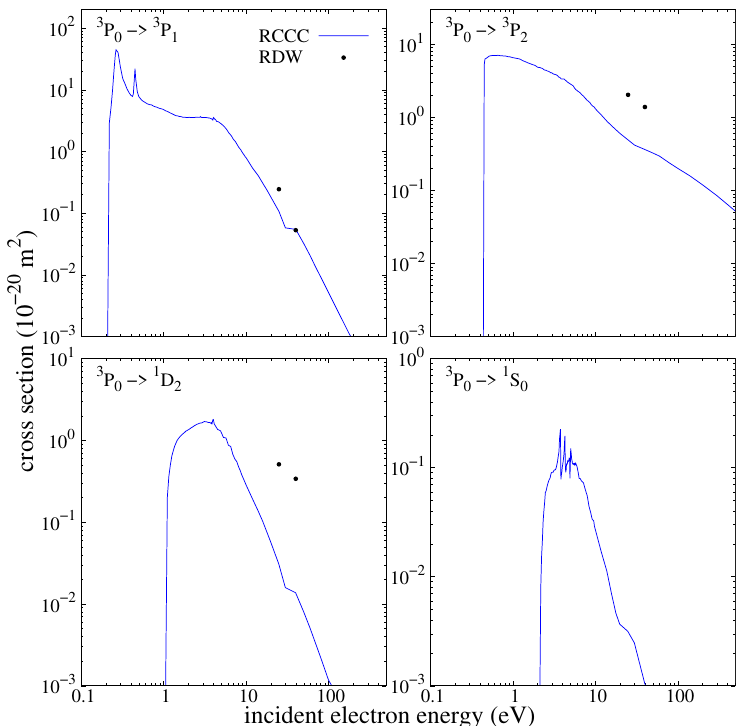
Figure 6. RCCC-integrated cross sections for excitations to the 5 p 2 manifold from the ground state. Comparison with the RDW results of Srivastava et al. [5] is